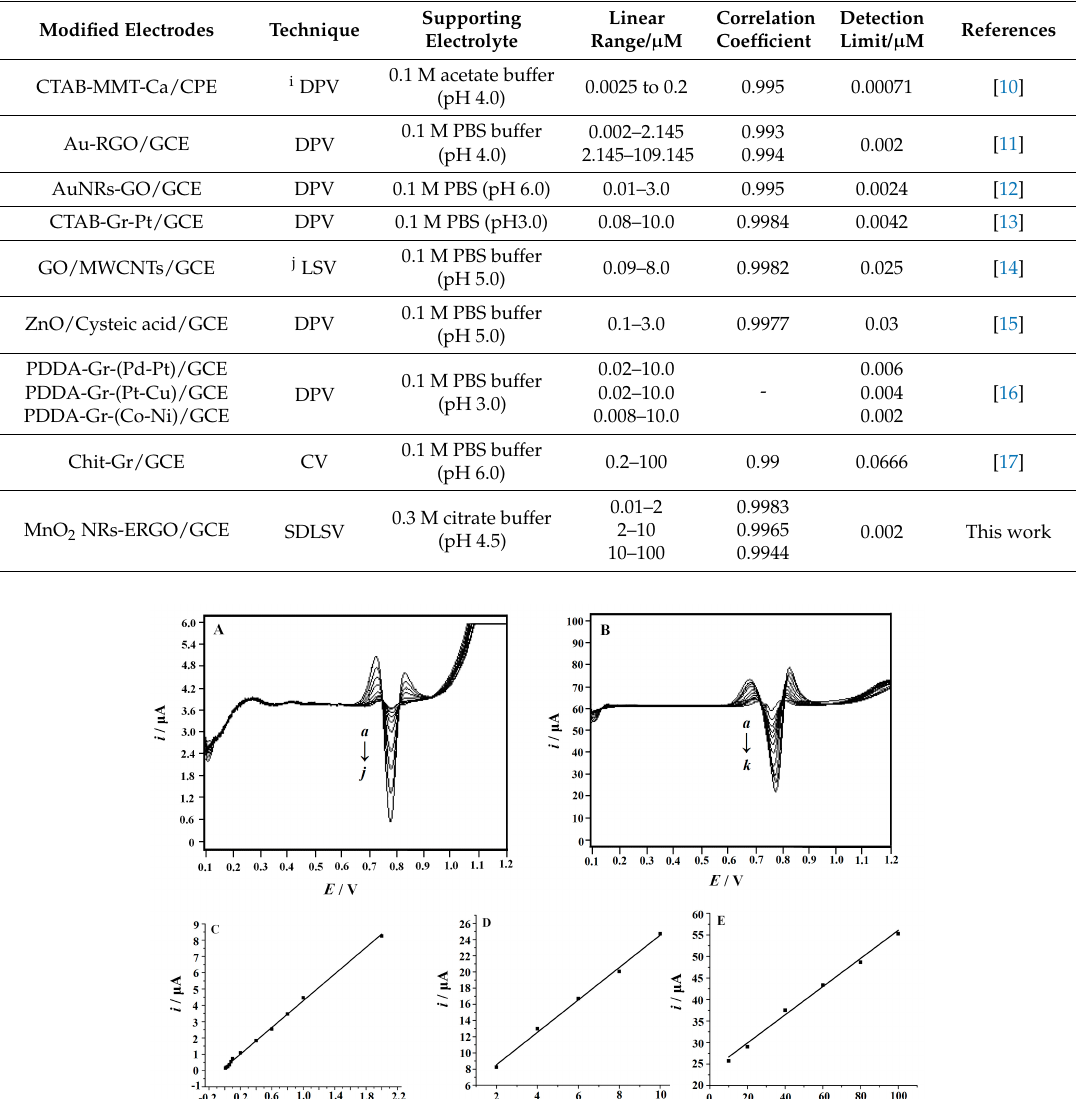
Table 2. Comparison of the linear range and detection limit with other modified electrodes for the determination of SY.